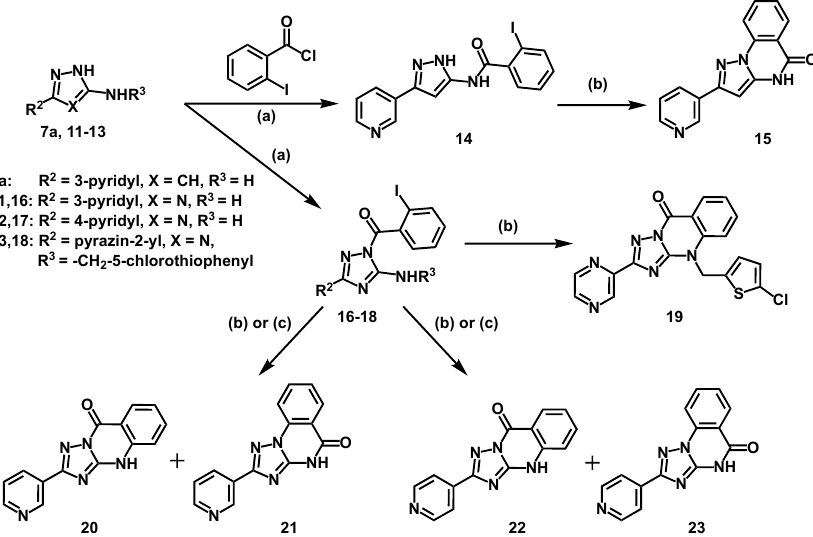
Scheme 2. Synthesis of aminopyrazol- and aminotriazole-based cyclic derivatives 15 , and 19 – 23 . ( a ) pyridine/THF, 0 ◦ C to r.t., 2–4 h, 14 63%, 16 , 78% 17 , 74% 18 59%; ( b ) CuI, Cs 2 CO 3 , 1,10-phenanthroline, DMF, 80 ◦ C, 0.5–1 h, 15 21%, 19 80%, 20 + 21 (1:1) 79%, 22 + 23 (3:7) 68%; ( c ) CuI, Cs 2 CO 3 , 1,10-phenanthroline, DMF, microwave irrad. at 150 ◦ C, 1 h, 20 + 21 (7:3) 92%, 22 + 23 (3:7) 95%.